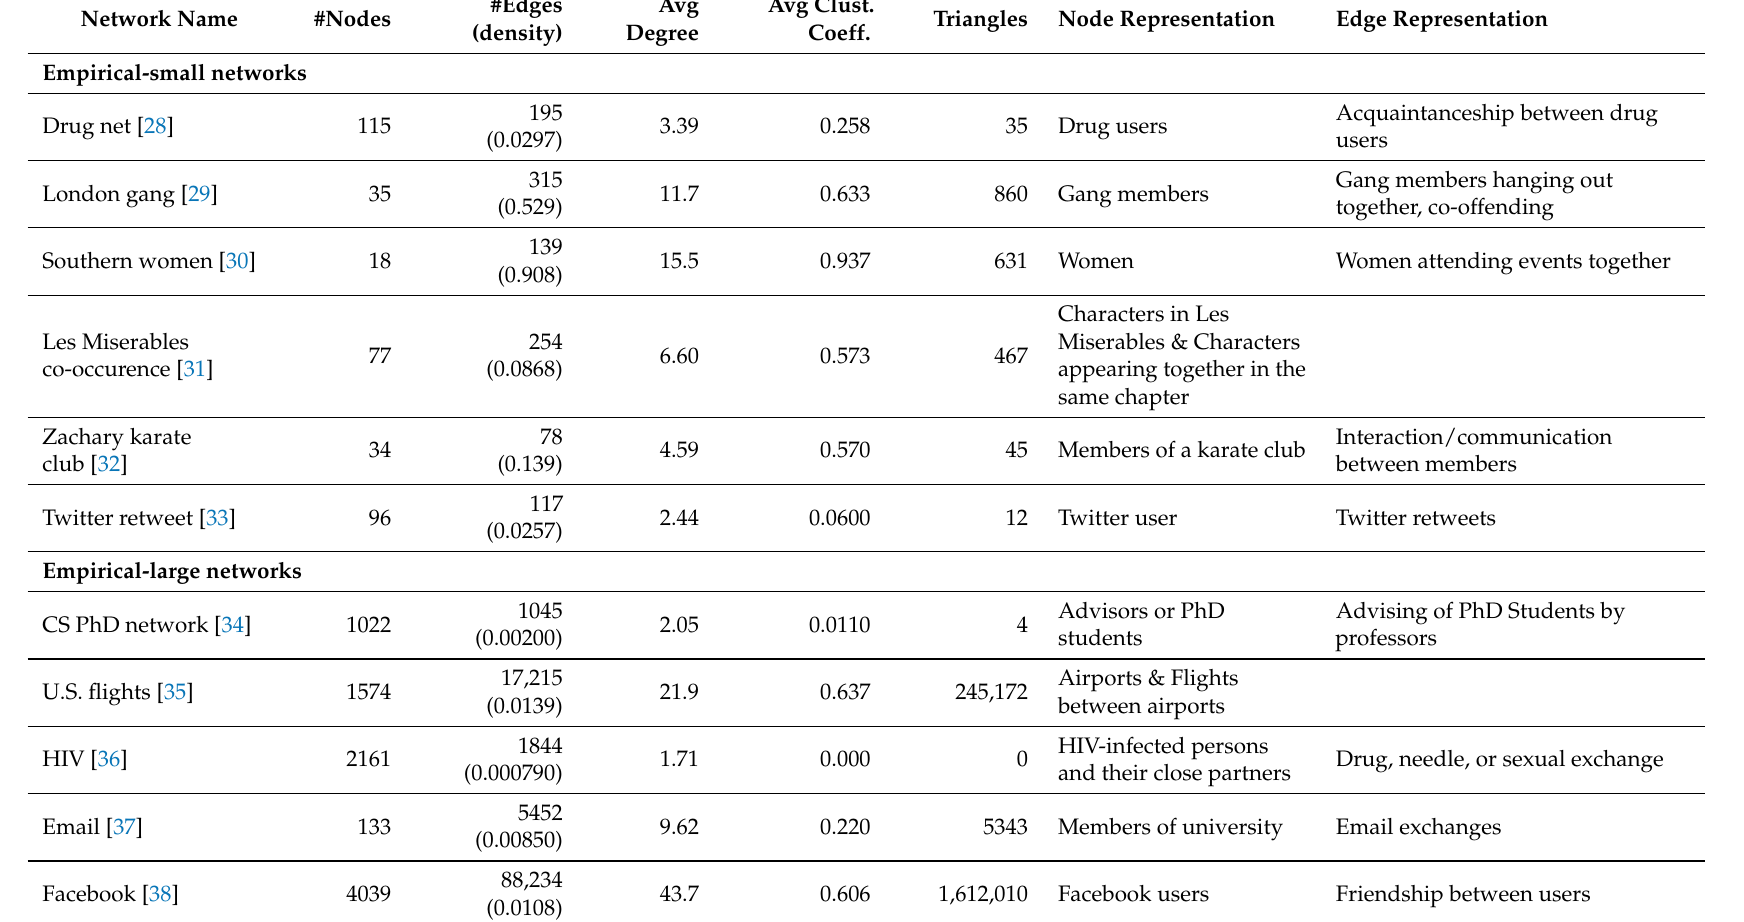
Table 3. Details on empirical network data